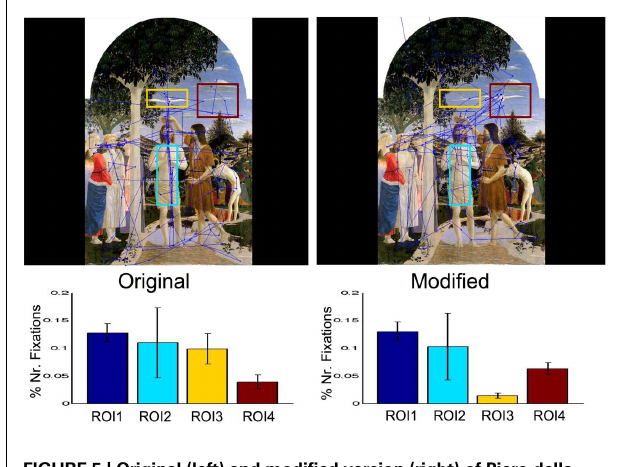
FIGURE 4 | Original (left) and modified version (right) of Rembrandt’s “Philosopher in meditation,” with the fixations of a subject superimposed. Although the modified version is just a cropping of the original, it appears to be more illuminated and the subject explored the whole painting, whereas in the original version he was more focused on the philosopher.The bottom plots show the relative average number of fixations in two regions of interest (ROI1 in blue and ROI2 in red).